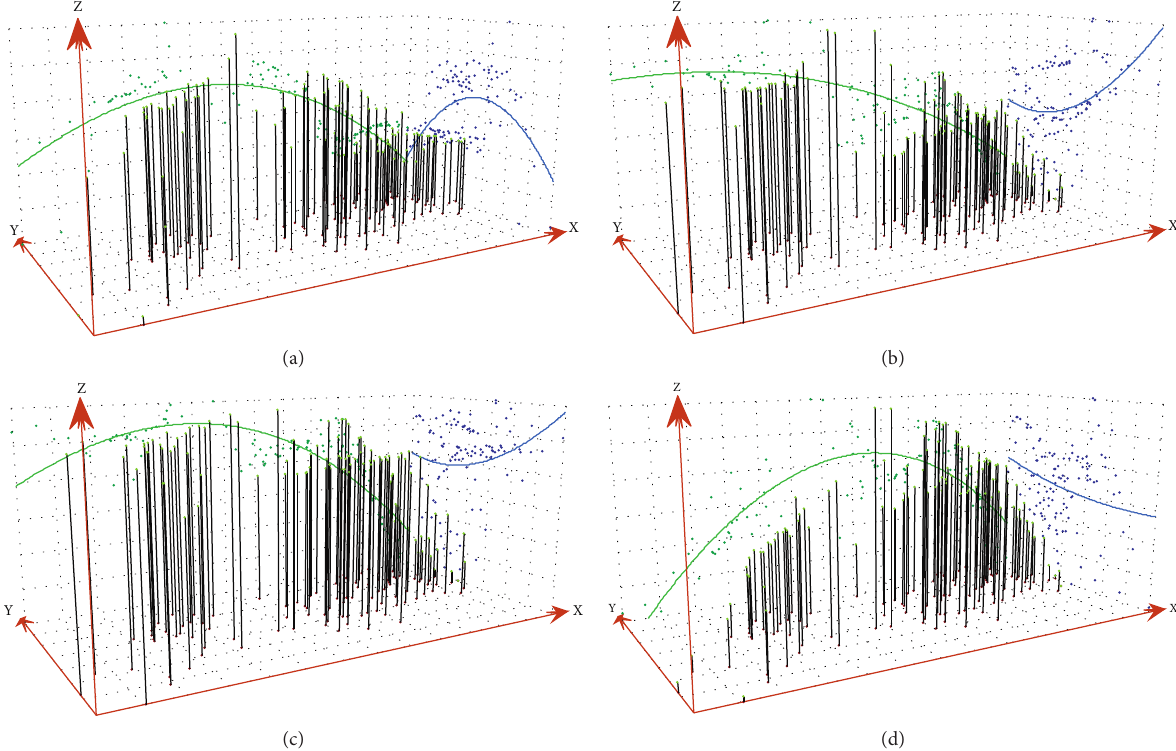
Figure 5: Spatial trend of independent variables. (a) Socioeconomy. (b) Educational development level. (c) Secondary industry. (d) Living